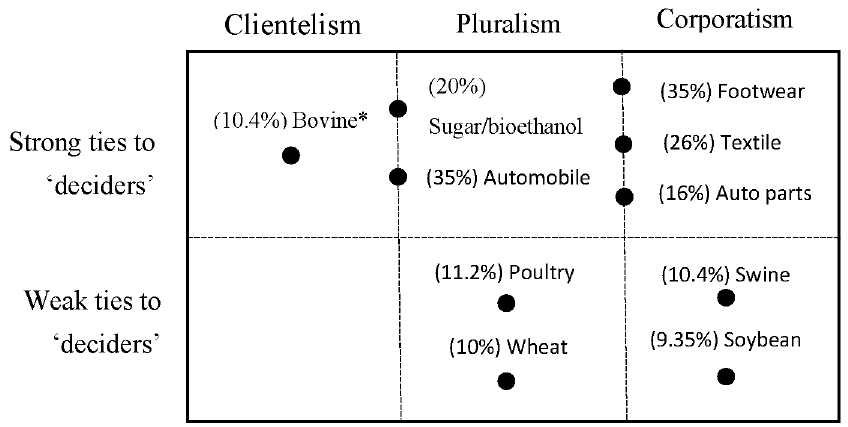
Figure 5. Common external tariff deviations and business associations matrix.